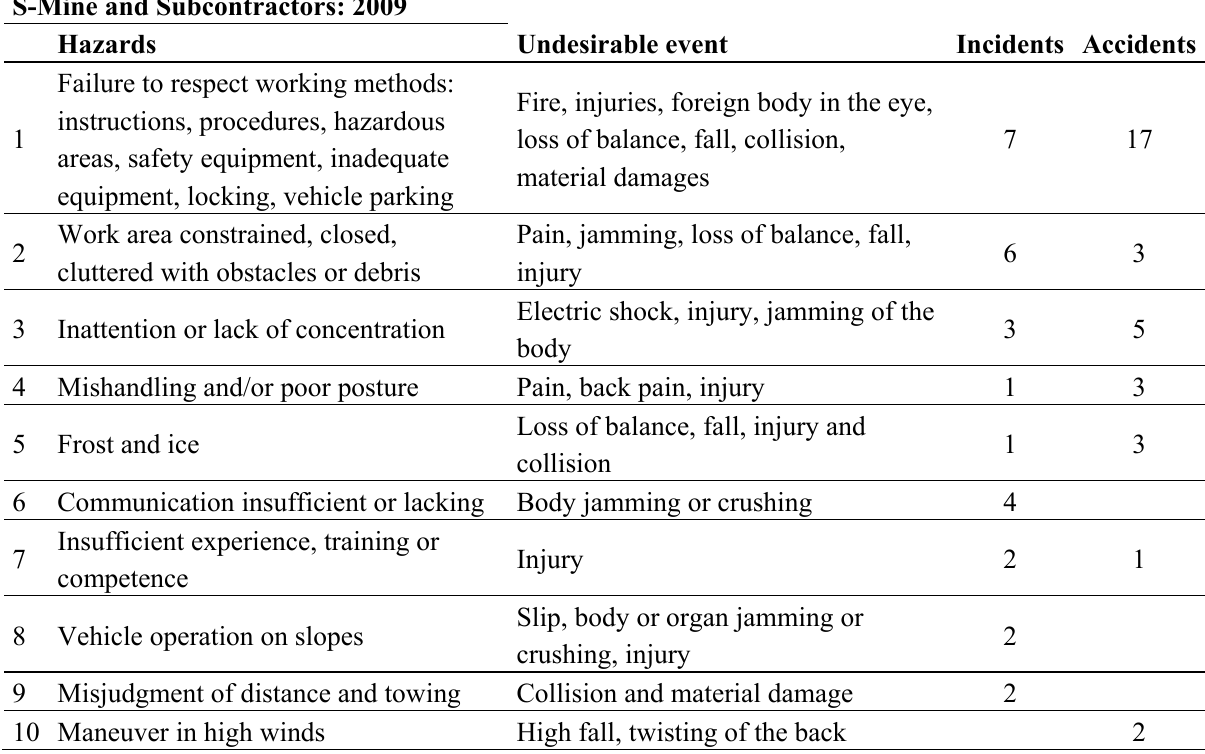
Table 1. Analysis of incidents and accidents (S-Mine and Subcontractors, 2009).